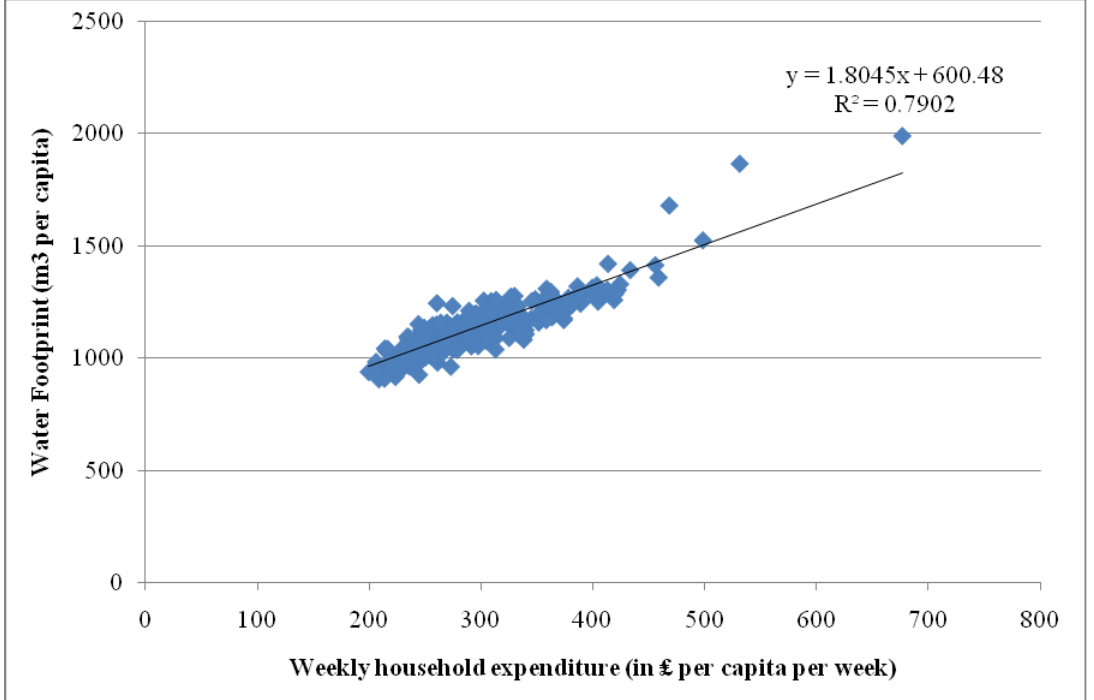
Figure 5. Relationship between per capita income in different local authorities in England and their average per capita consumption water